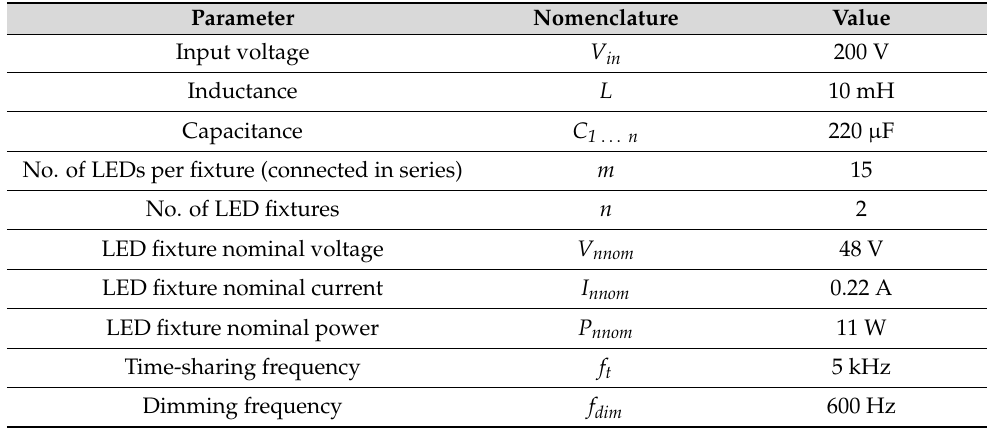
Table 1. Experimental test bench